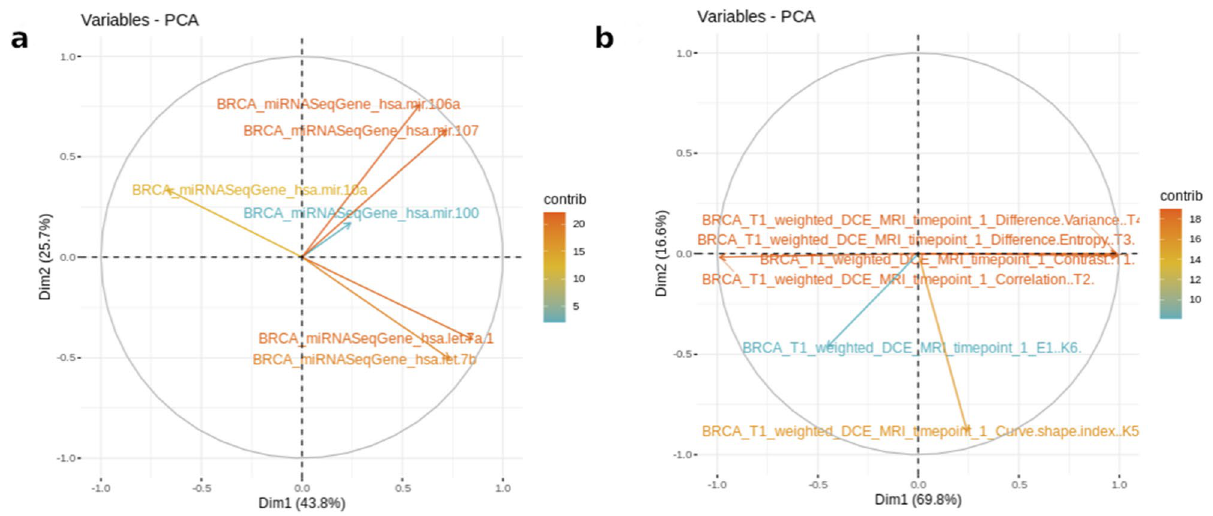
Figure 9. An example of feature selection module via PCA for stage II. Feature Selection module is one of the downstream analysis modules. In this case, on the left-hand side ( a ), we extracted the PCA correlation circle plot for radiomic in stage II. On the right-hand side ( b ), we extracted the PCA correlation circle plot for genomic features in stage II. The most important or contributing variables are highlighted on the correlation circle plot for PCA. The figure is generated by using R software version 3.6.1 (https ://www.r-proje